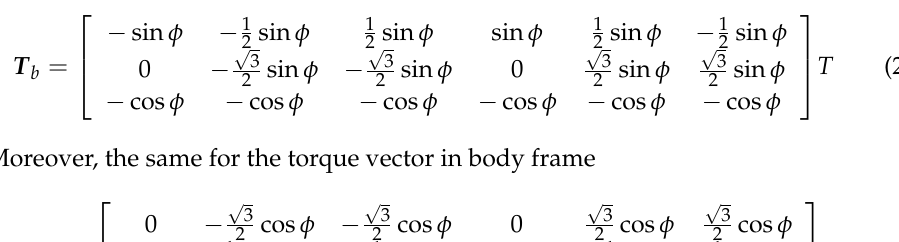
(cid:3) T T 6 be the vector composed of the thrusts of